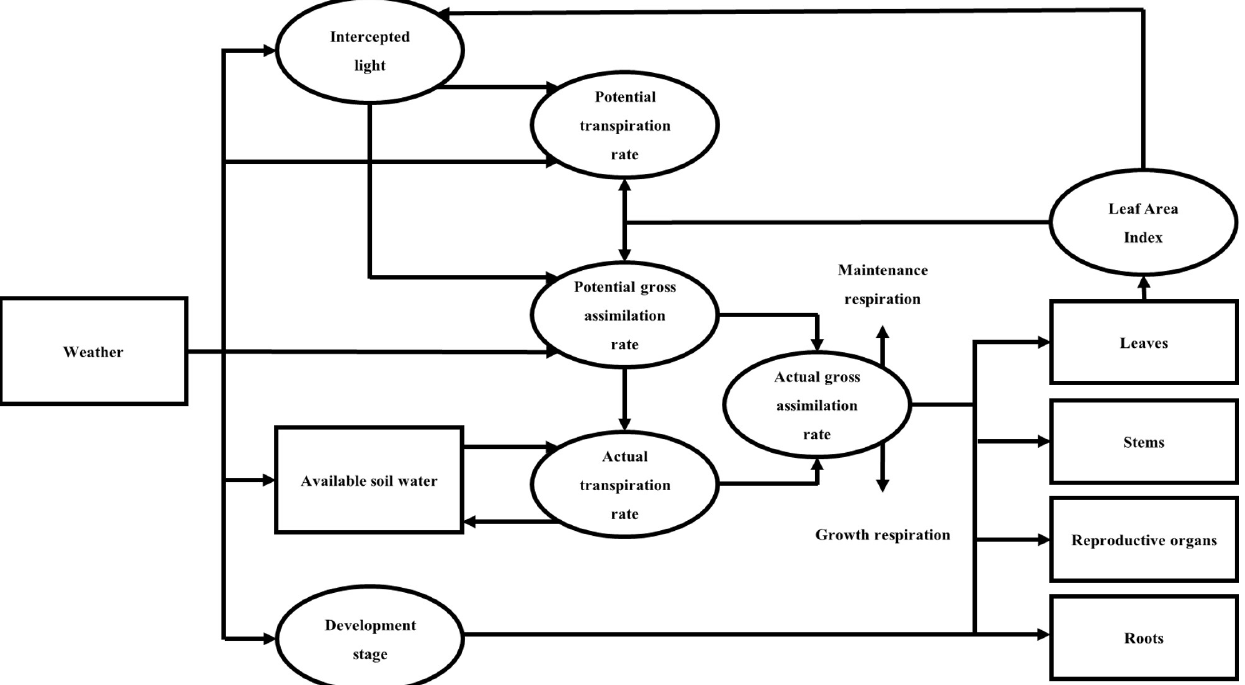
Figure 2. General simple structure of a dynamic plant growth model